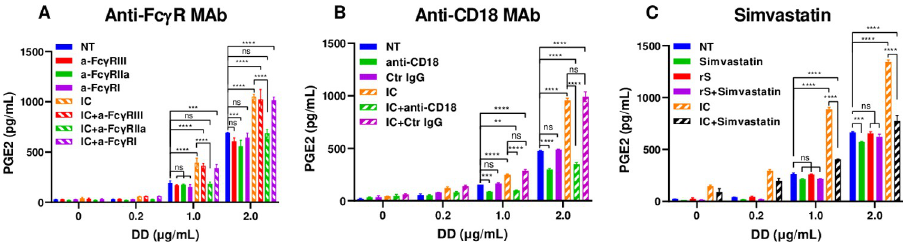
Fig 2. Inhibition of Fc γ RIIa and of CD18 reduced PGE2 production in human monocytes activated with spike- IgG IC in the presence of DD. Monocytes were left not treated (NT, in A-C) or were treated with anti-Fc γ R MAbs alone: anti-Fc γ RIII, anti-Fc γ RIIa, or anti-Fc γ RI MAbs (A), or with anti-CD18 MAbs or control IgG (Ctr IgG) alone (B) or with IC rS+S-cIgG alone (A and B), or with IC in the presence of anti-Fc γ R MAb: IC+anti-Fc γ RIII, IC+anti- Fc γ RIIa, or IC+anti-Fc γ RI (A) or with IC in the presence of anti-CD18 MAb or control IgG, IC+anti-CD18 and IC +Ctr IgG, respectively (B) and were incubated alone or in the presence of DD. (C) Monocytes were incubated with Simvastatin alone (8 nM), with rS protein alone or with rS+S-cIgG IC alone (IC) or with rS or IC in the presence of simvastatin, rS+Simvastatin and IC+Simvastatin, respectively, alone or in the presence of DD. Cell culture supernatants were collected and PGE2 concentrations were determined by FRET assay (A-C). Mean PGE2 concentrations ± SD calculated for triplicate wells are shown for a representative of three experiments performed with cells from individual donors. � P � 0.01, �� P � 0.001, ��� P � 0.0001, by two-way ANOVA using Tukey’s multiple comparison test.